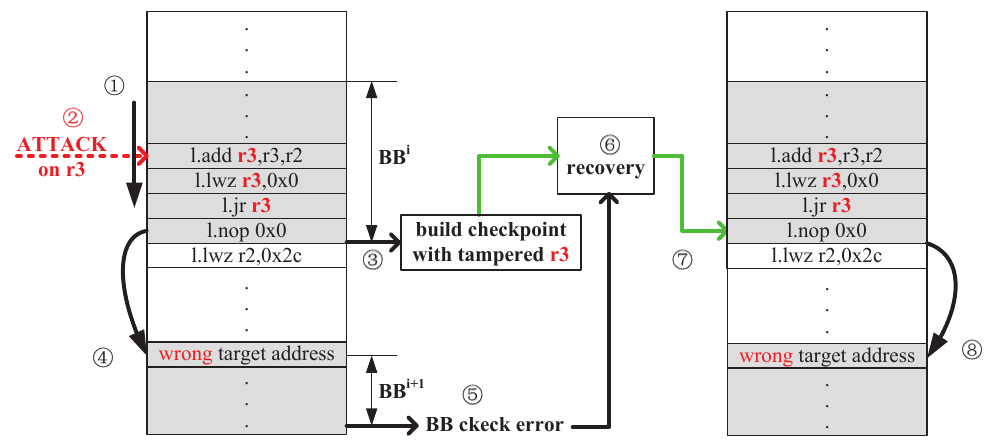
Figure 7. The failure case of BB-oriented backup and recovery method.